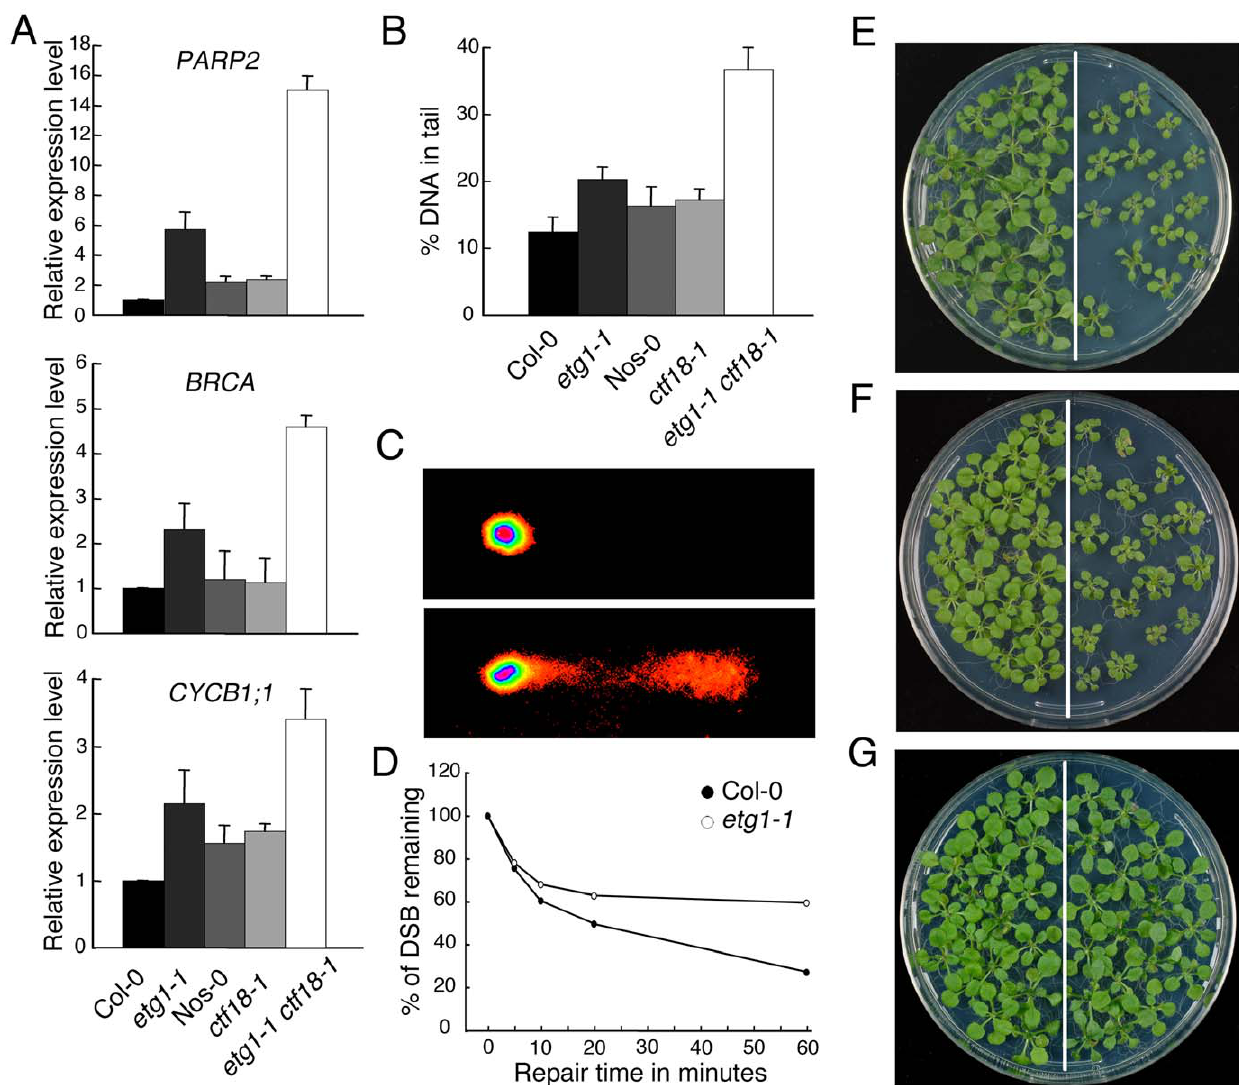
Figure 6. Inefficient DNA repair upon loss of sister chromatid cohesion. (A) Real-time RT-PCR analysis of DNA stress-inducible genes PARP2 , BRCA , and CYCB1;1 in wild-type (Col-0), etg1-1 , wild-type (Nos-0), ctf18-1 , and etg1-1 ctf18-1 plants. Total RNA prepared from 8-day-old seedlings was amplified by RT-PCR. All values were normalized against the expression level of the ACTIN2 gene. (B) Statistical analysis of a comet assay. The average %-values of DNA in tails of nuclei of 7-day-old wild-type (Col-0), etg1-1 , wild-type (Nos-0), ctf18-1 , and etg1-1 ctf18-1 seedlings. Error bars indicate SD. (C) Examples of comets from plant nuclei with undamaged (top) or damaged (bottom) DNA. (D) Kinetics of DSB repair in wild-type versus etg1-1 mutant plants. Fractions of remaining DSB were calculated for 0, 5, 10, 20, and 60 min recovery time after treatment with 50 m g/ml bleomycin for 1 h. Maximum damage was normalized as 100% at t=0. (E–G) Wild-type (Col-0, left) and etg1-1 (right) plants were grown on medium holding 50 ppm methyl methane sulfonate (E), 3 m g/ml mitomycin C (F), or no supplement (G). Plants were photographed 3 weeks after